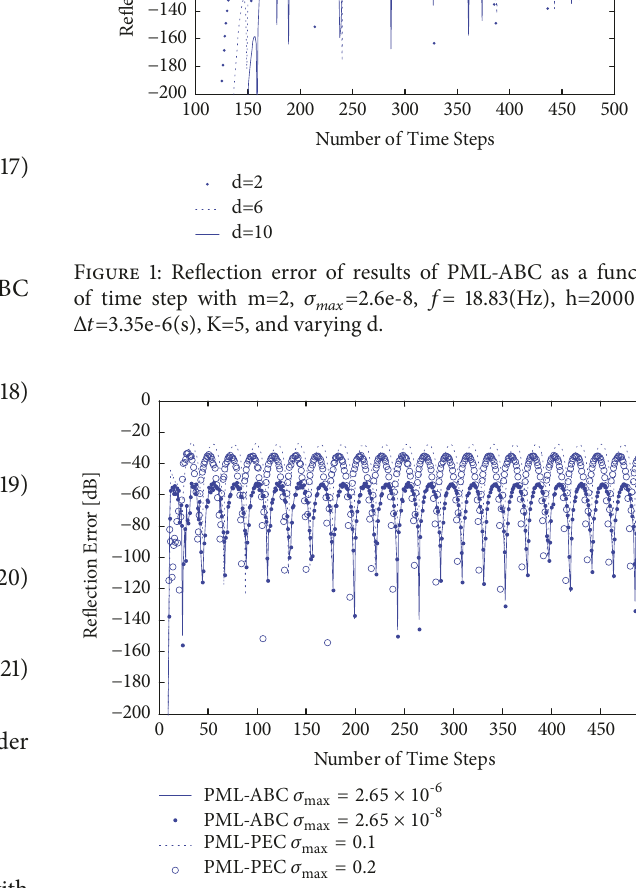
Figure 2: Reflection error of results of PML-ABC and PML-PEC as a function of time step with d=2, m=2, 𝑓 =1.88e+11(Hz), h=0.01(m), Δ𝑡 =2.37e-10(s), K=94, and varying 𝜎 𝑚𝑎𝑥 .